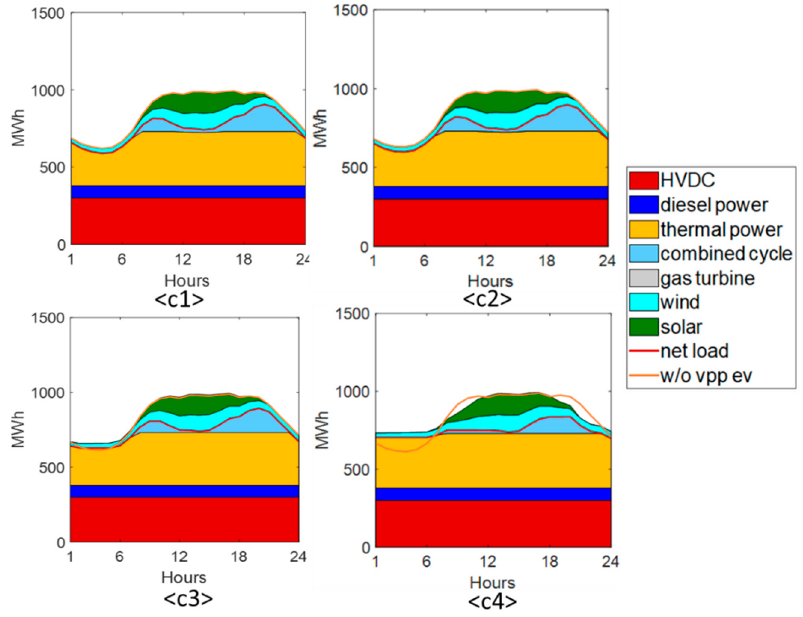
Figure 8. Expected dispatch profiles for summer peak day in 2019.